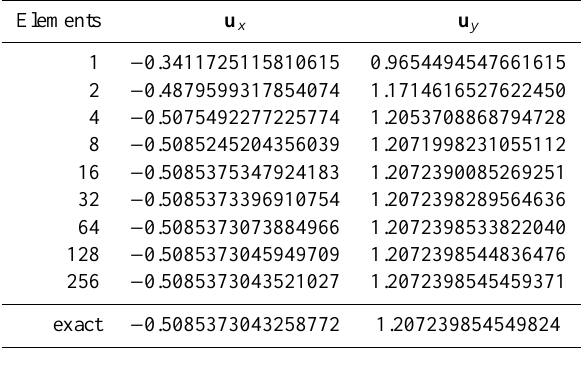
Table 1. Convergence analysis (order 4) of the axial and transverse displacement at the tip of the cantilever beam in Sect. 6.2 compared to the exact solution stated in Gerstmayr and Irschik (2008). Elements u x